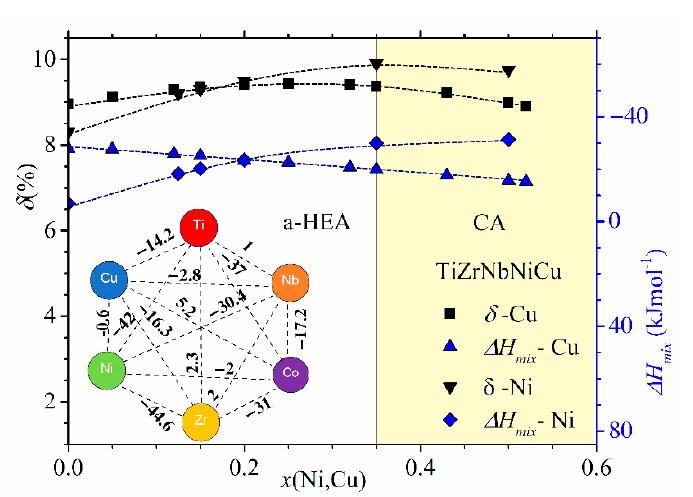
Figure 2. Atomic size mismatch δ and mixing enthalpy ∆ H mix of (TiZrNbCu) 1 − x Ni x and (TiZrNbNi) 1 − x Cu x alloys vs. x . The inset: ∆ H mix between the constituent elements.